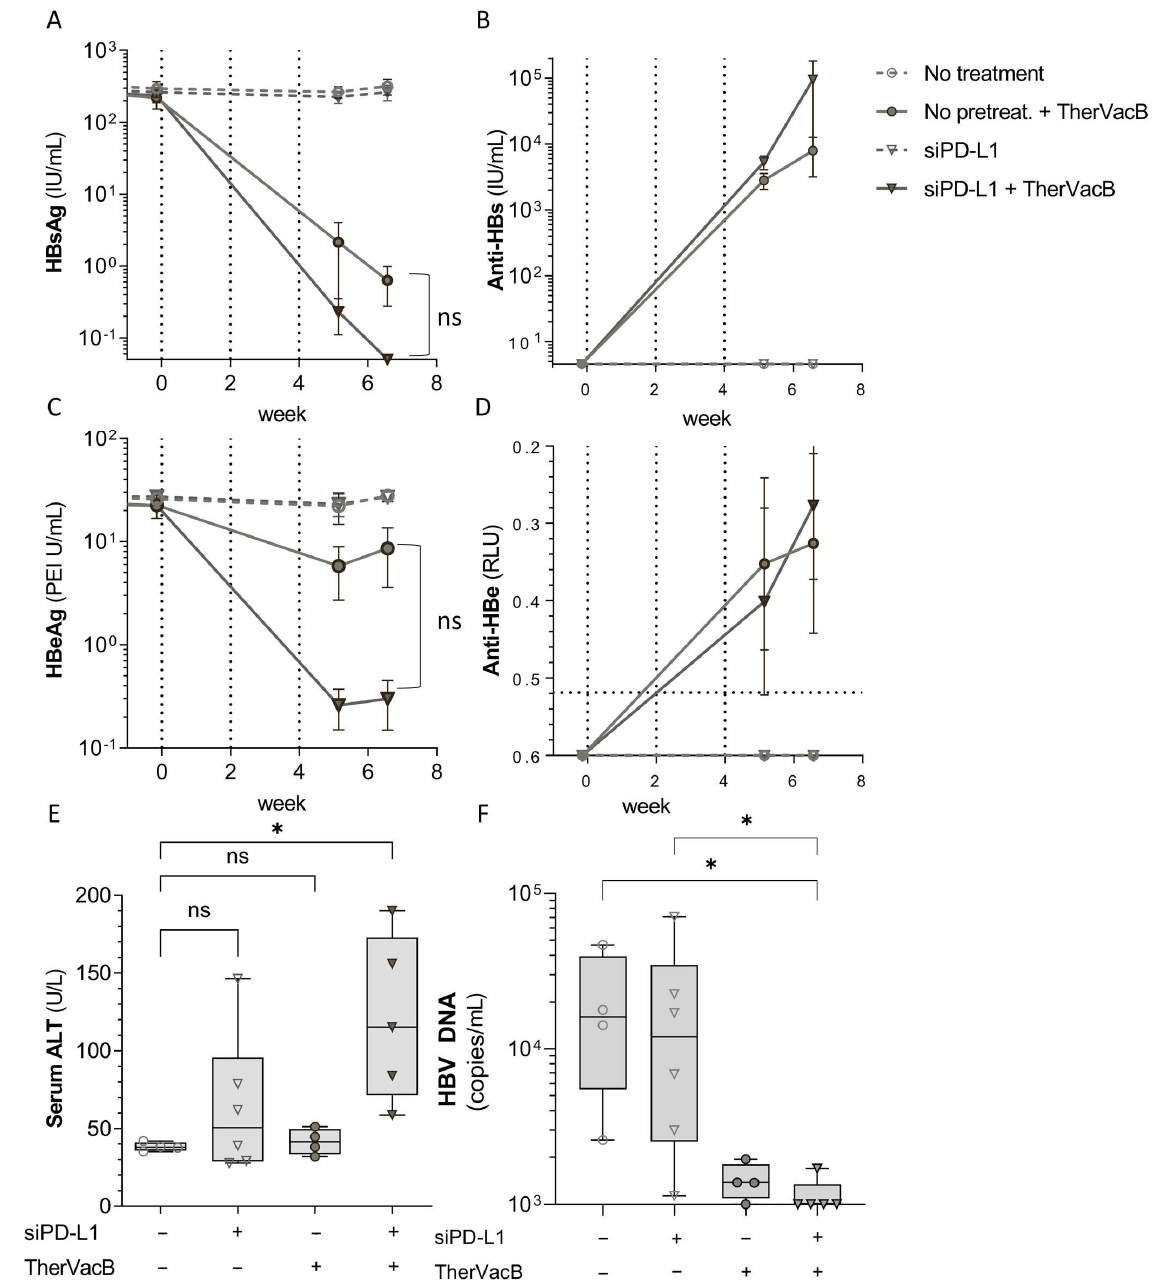
Figure 2. Antiviral efficacy of a combination of siPD-L1 and TherVacB . ( A – E ) Bl6 mice were infected intravenously with AAV-HBV resulting in persistent HBV replication. After nine weeks, mice were vaccinated two times using a combination of HBc and HBsAg adjuvanted with c-di-AMP (week 0 and week 2), and one time using an MVA expressing HBV core and S (week 4) (arrows in the graph indicate vaccinations); 1 mg/kg siRNA was administered i.v. one day prior to each vaccination. Mice were sacrificed at week 7 after start of vaccination. ( A ) HBsAg, ( B ), anti-HBs ( C ) HBeAg and ( D ) anti-HBe were measured in at indicated timepoints (arrows in the graph represent timepoints of vaccination). ( E ) Serum ALT activity was measured at the final timepoint. ( F ) Serum HBV DNA was measured using RT-qPCR at the final timepoint. ( A – D ) Graphs show mean and standard error of the mean (whiskers). Statistical analyses were performed using two-way ANOVA with Bonferroni correction for multiple comparison. ( E ) Box plots show median, interquartile ratio (IQR) (box), and minimum to maximum (whiskers). Data from six animals per group are shown. Repeated measure one-way ANOVA with Dunnett’s multiple comparison correction; * p <